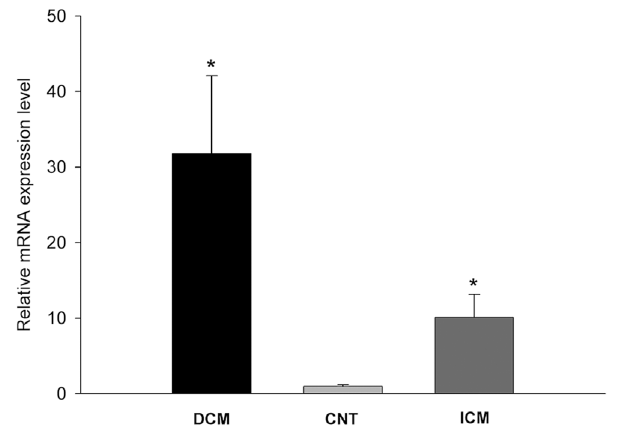
Figure 3. Levels of proANP mRNA expression determined by RNA-seq. The values from the CNT group were set to 1. The data are expressed as mean 6 SEM in mRNA relative expression. DCM, dilated cardiomyopathy; ICM, ischemic cardiomyopathy; CNT, control. *p , 0.0001.